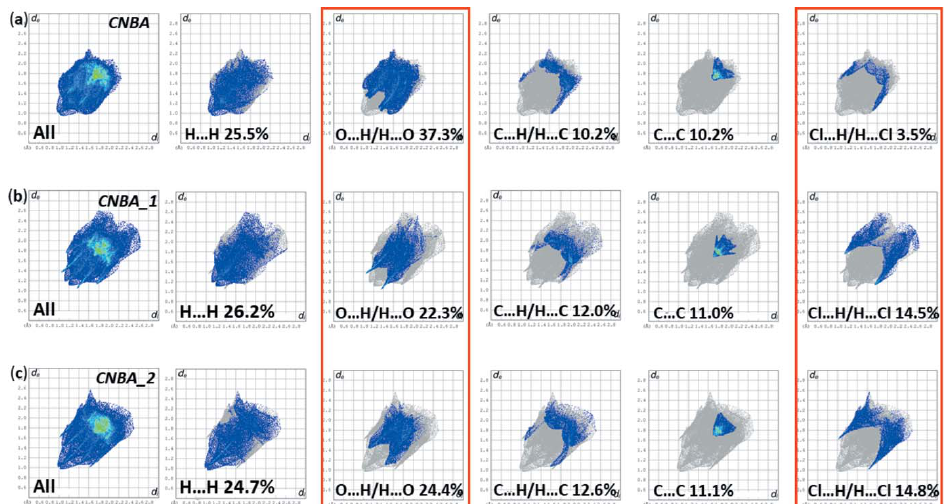
Figure 7 ( a ) The full two-dimensional fingerprint plot for CNBA, and fingerprint plots delineated into H (cid:3)(cid:3)(cid:3) H, O (cid:3)(cid:3)(cid:3) H/H (cid:3)(cid:3)(cid:3) O, C (cid:3)(cid:3)(cid:3) H/H (cid:3)(cid:3)(cid:3) C, C (cid:3)(cid:3)(cid:3) C and Cl (cid:3)(cid:3)(cid:3) H/ H (cid:3)(cid:3)(cid:3) Cl contacts, ( b ) the full two-dimensional fingerprint plot for CNBA_1, and fingerprint plots delineated into H (cid:3)(cid:3)(cid:3) H, O (cid:3)(cid:3)(cid:3) H/H (cid:3)(cid:3)(cid:3) O, C (cid:3)(cid:3)(cid:3) H/H (cid:3)(cid:3)(cid:3) C, C (cid:3)(cid:3)(cid:3) C and Cl (cid:3)(cid:3)(cid:3) H/H (cid:3)(cid:3)(cid:3) Cl contacts, ( c ) the full two-dimensional fingerprint plot for CNBA_2, and fingerprint plots delineated into H (cid:3)(cid:3)(cid:3) H, O (cid:3)(cid:3)(cid:3) H/H (cid:3)(cid:3)(cid:3) O, C (cid:3)(cid:3)(cid:3) H/H (cid:3)(cid:3)(cid:3) C, C (cid:3)(cid:3)(cid:3) C and Cl (cid:3)(cid:3)(cid:3) H/H (cid:3)(cid:3)(cid:3) Cl